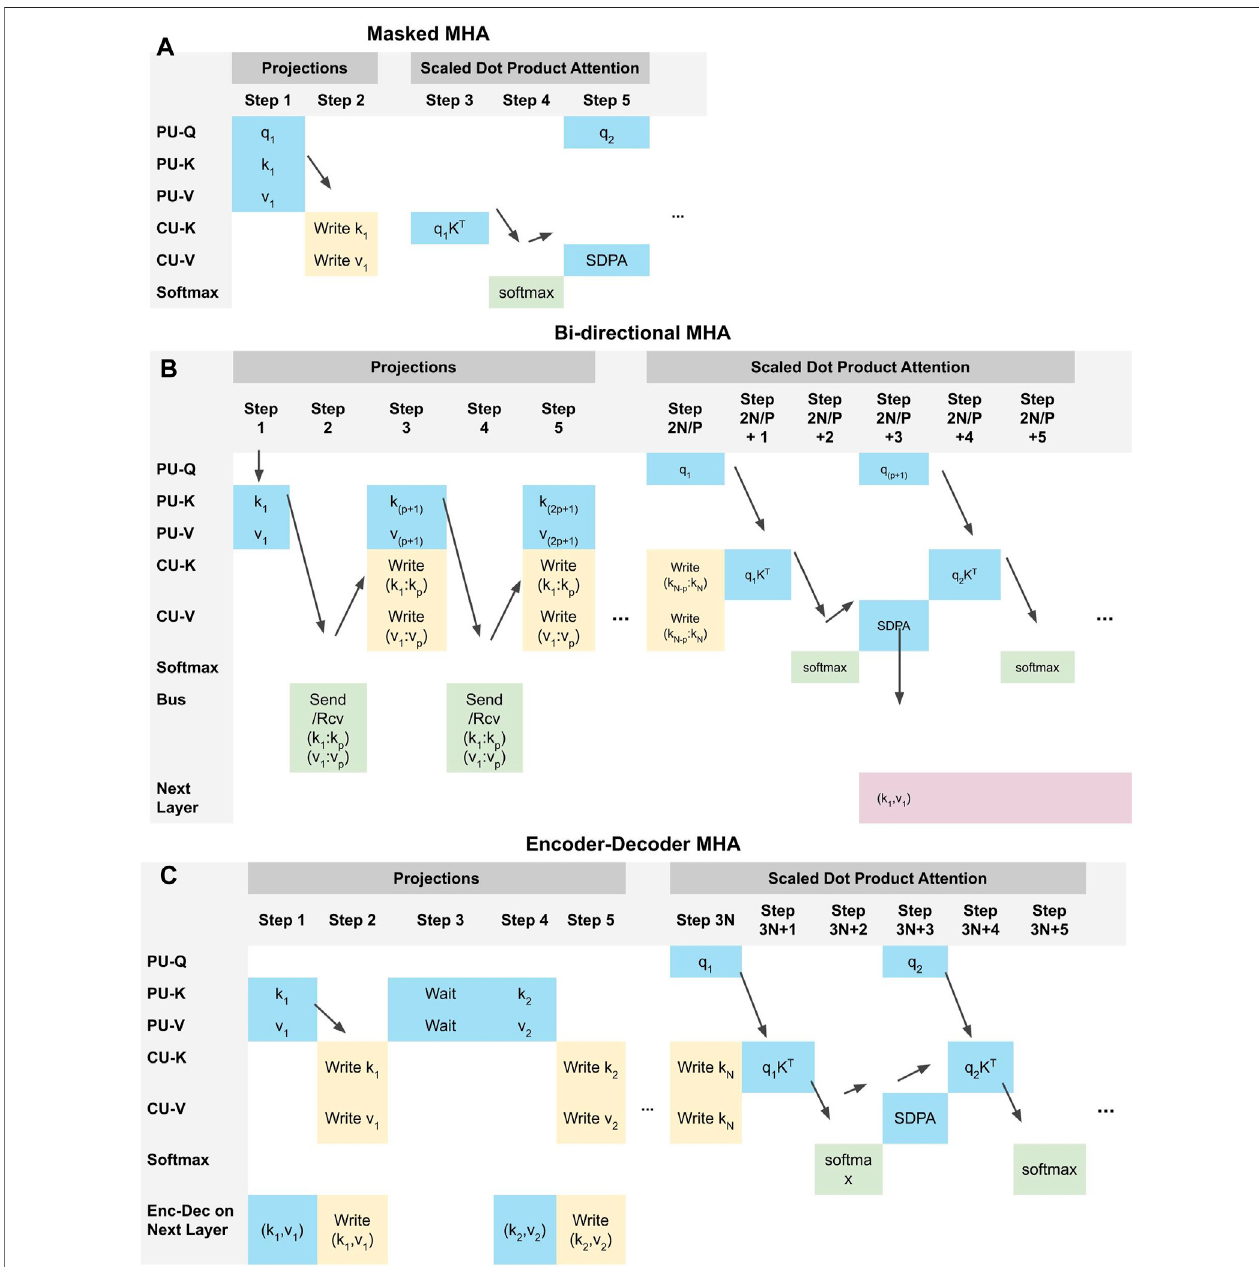
FIGURE 4 | The timeline of implementation for the different types ofMHA namely masked MHA (A) , bi-drectional MHA (B) and encoder-decoder MHA (C) . The bi- directional MHA uses model parallelism across multiple AHUs while the encoder-decoder MHA parallelizes the computation of the keys and values across different decoder